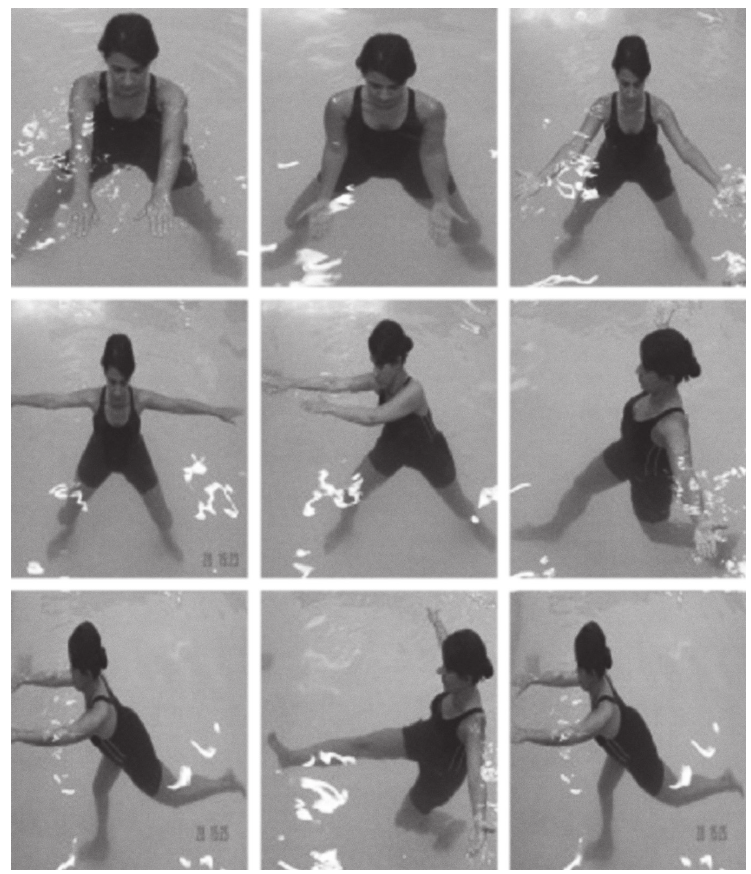
Figura 1 - Movimentos da técnica Ai